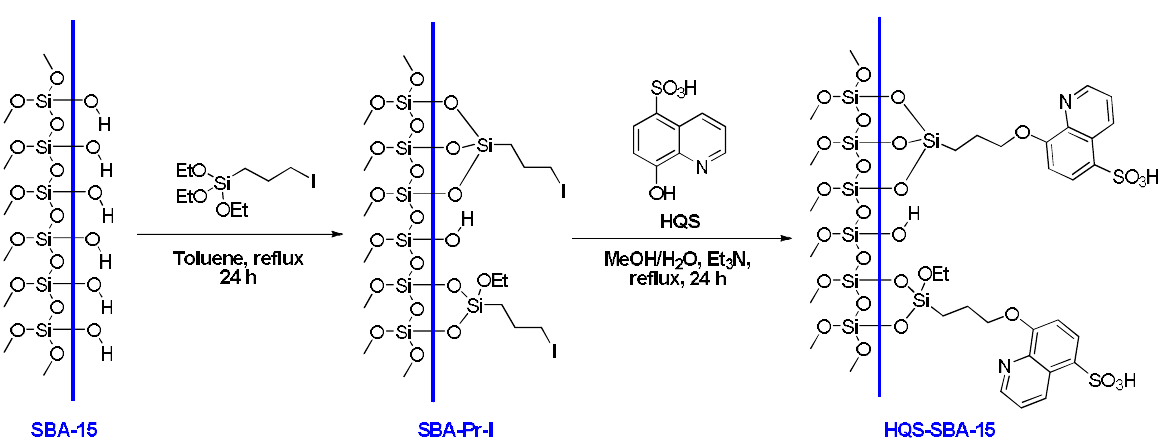
Fig. 8. The overall synthesis procedure of 8-hydroxyquinoline-5-sulfonic acid functionalized ordered nanoporous of SBA-15